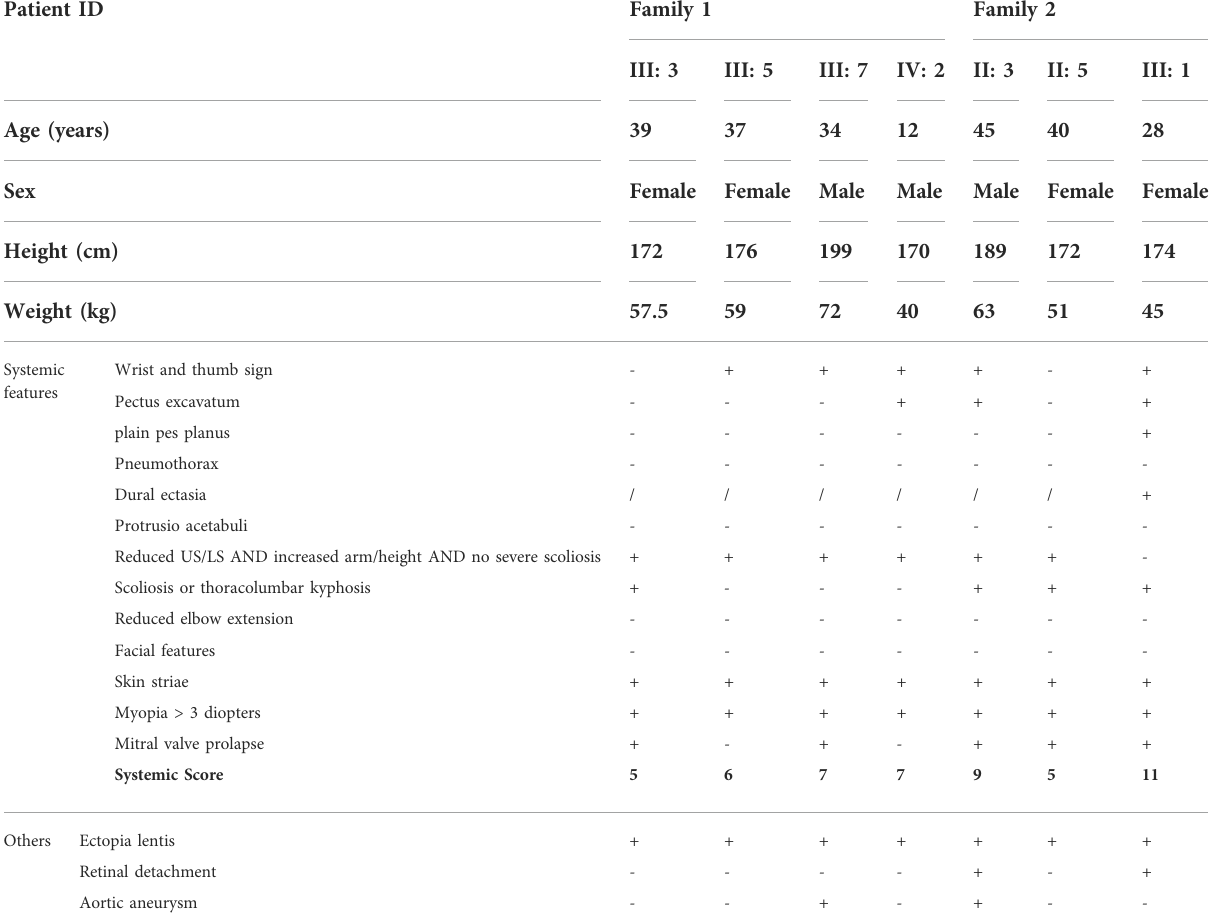
TABLE 1 The clinical features of patients with Marfan syndrome identi fi ed in the present study. Patient